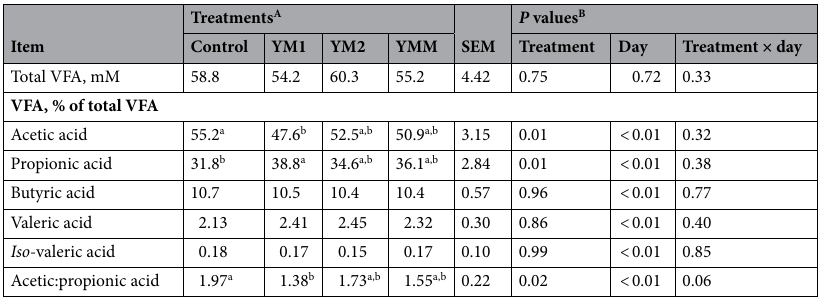
Table 2. Effects of direct-fed microbials (DFM) on volatile fatty acids (VFA) concentration on a 24 h pool from feeding in a dual-flow continuous culture system. A All treatments had the same basal diet (1 mL of each DFM was applied per day at 1 × 10 8 cfu/mL); treatments were: Control, carrier of additives without DFM; YM1, S. cerevisiae and M. elsdenii strain 1; YM1, S. cerevisiae and M. elsdenii strain 2; YMM, S. cerevisiae and M. elsdenii strain 1 (1/2 dose) and strain 2 (1/2 dose). B Statistical differences were declared at P ≤ 0.05 or as a trend to be different if P > 0.05 and < 0.10.